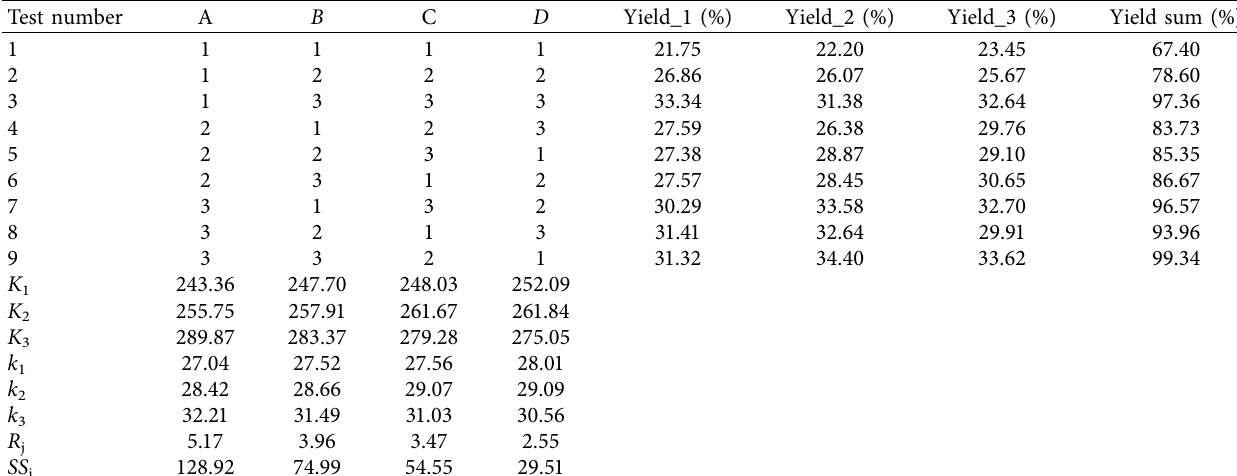
Table 3: Range analysis of CFs